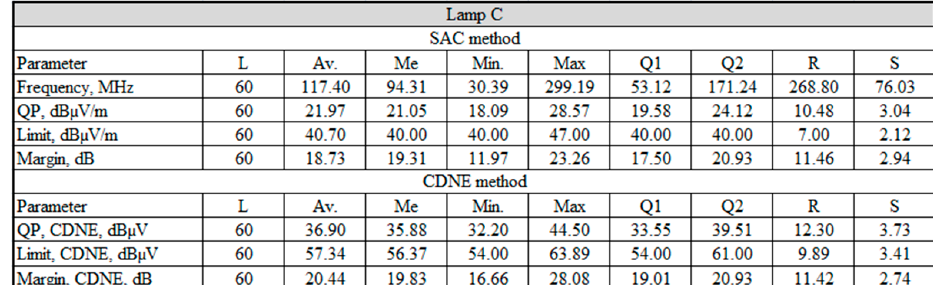
Figure 12. Recorded QP values using the new and traditional method against the allowable limits for the 15 W LED lamp C under test, where: L—number of analysed values; AV—calculated average value; Min, Max—minimum and maximum values; Q1, Me(Q2), Q3—first, second and third quartile; R—range; and S—standard deviation.